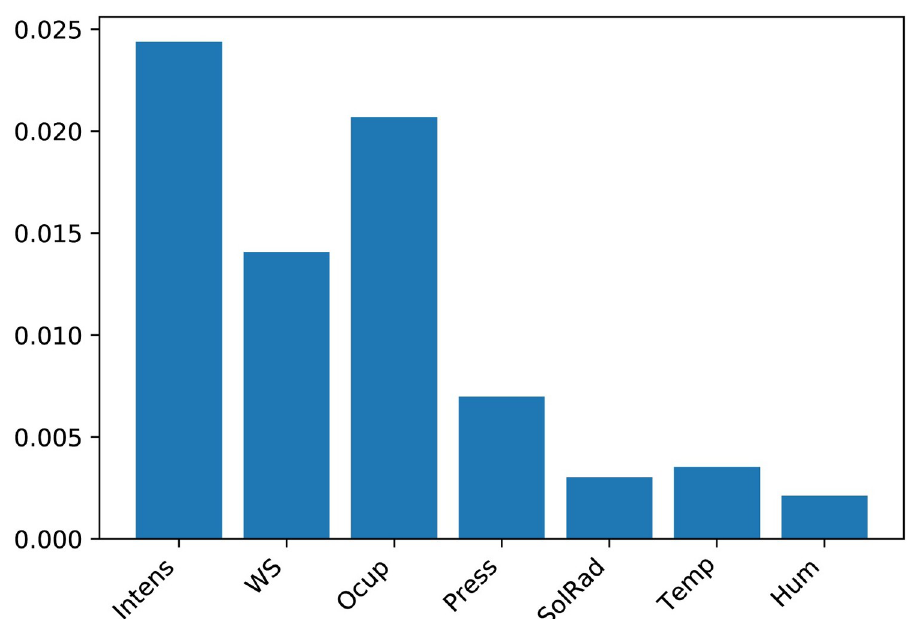
Fig 7. The feature importance scores based on mutual